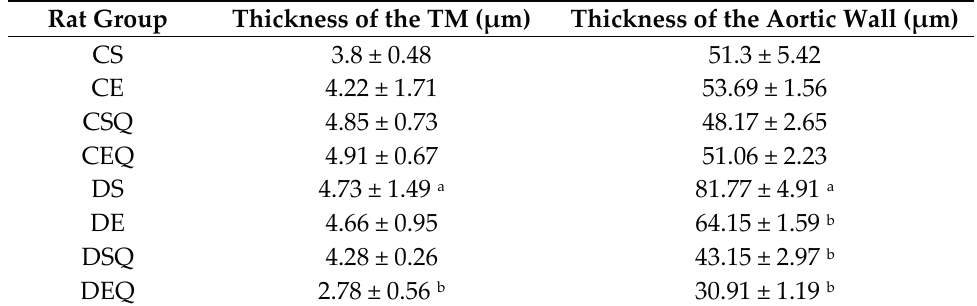
Table 2. Measurements of the tunica media (TM) thickness of the aortic wall and aortic wall in experimental